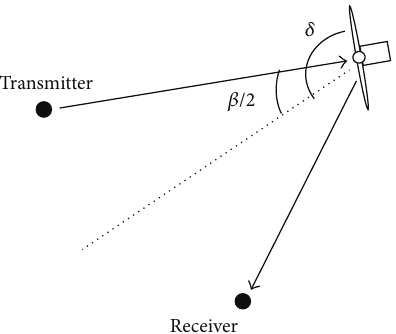
Figure 2: Geometry for bistatic Doppler in the horizontal plane.